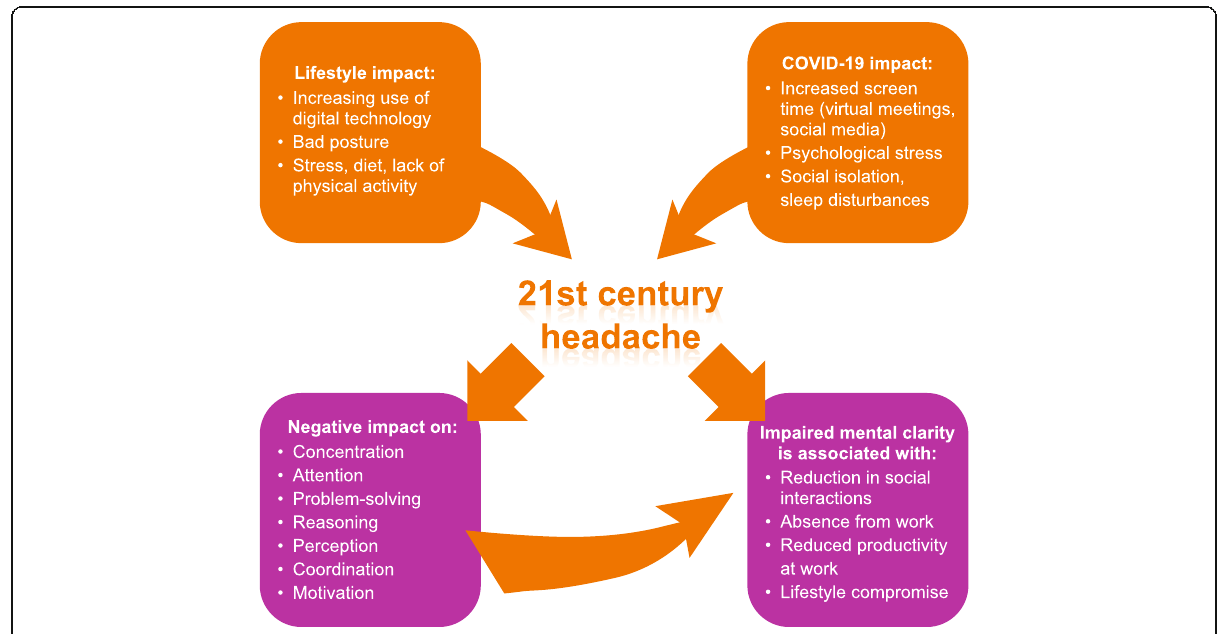
Fig. 1 Triggers, suspected impact and burden of 21st century